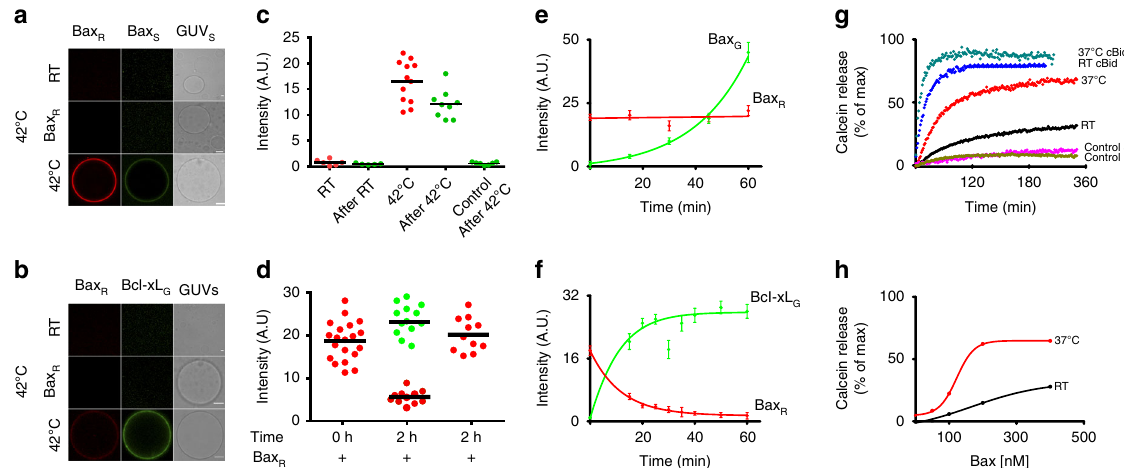
Fig. 7 Bax auto-activation and retrotranslocation in model membranes. a Bax G binding to GUVs (30% CL) with or without membrane-embedded Bax R at room temperature (RT) and after incubation at 42 °C for 30 min. (Scale bar: 10 µ m). b Binding of Bcl-xL G to 30% CL GUVs containing or not Bax R at RT and 42 °C for 30 min. c Quanti fi cation of Bax R (red dots) and Bax G ( green dots ) binding to individual GUVs before and after incubation at RT or 42 °C. The control corresponds to samples treated at 42 °C but in the absence of Bax R . ( Black line represents mean of the distribution). d Quanti fi cation of Bax R ( red dots ) and Bcl-xL G ( green dots ) binding to individual GUVs after heat activation (0 h after Bcl-xL addition) and after 2 h incubation at RT in presence and absence of Bcl-xL. ( Black line represents mean of the distribution). e Temporal evolution of Bax R (previously bound by incubation at 42 °C) and Bax G intensity on GUVs at RT. (Error bars represent s.d. of n = 3 experiments). f Temporal evolution of Bax R (previously bound by incubation at 42 °C) and Bcl-xL G intensity on GUVs at RT. (Error bars represent s.d. of the average intensity of all GUVs in three experiments). g Kinetics of calcein release from LUVs, comparing 200 nM Bax activity at ∼ 37 °C and RT in the presence and absence of 20 nM cBid. h Dose response curve of % calcein release at varying Bax concentration at ∼ 37 °C as compared to RT. For all experiments n =